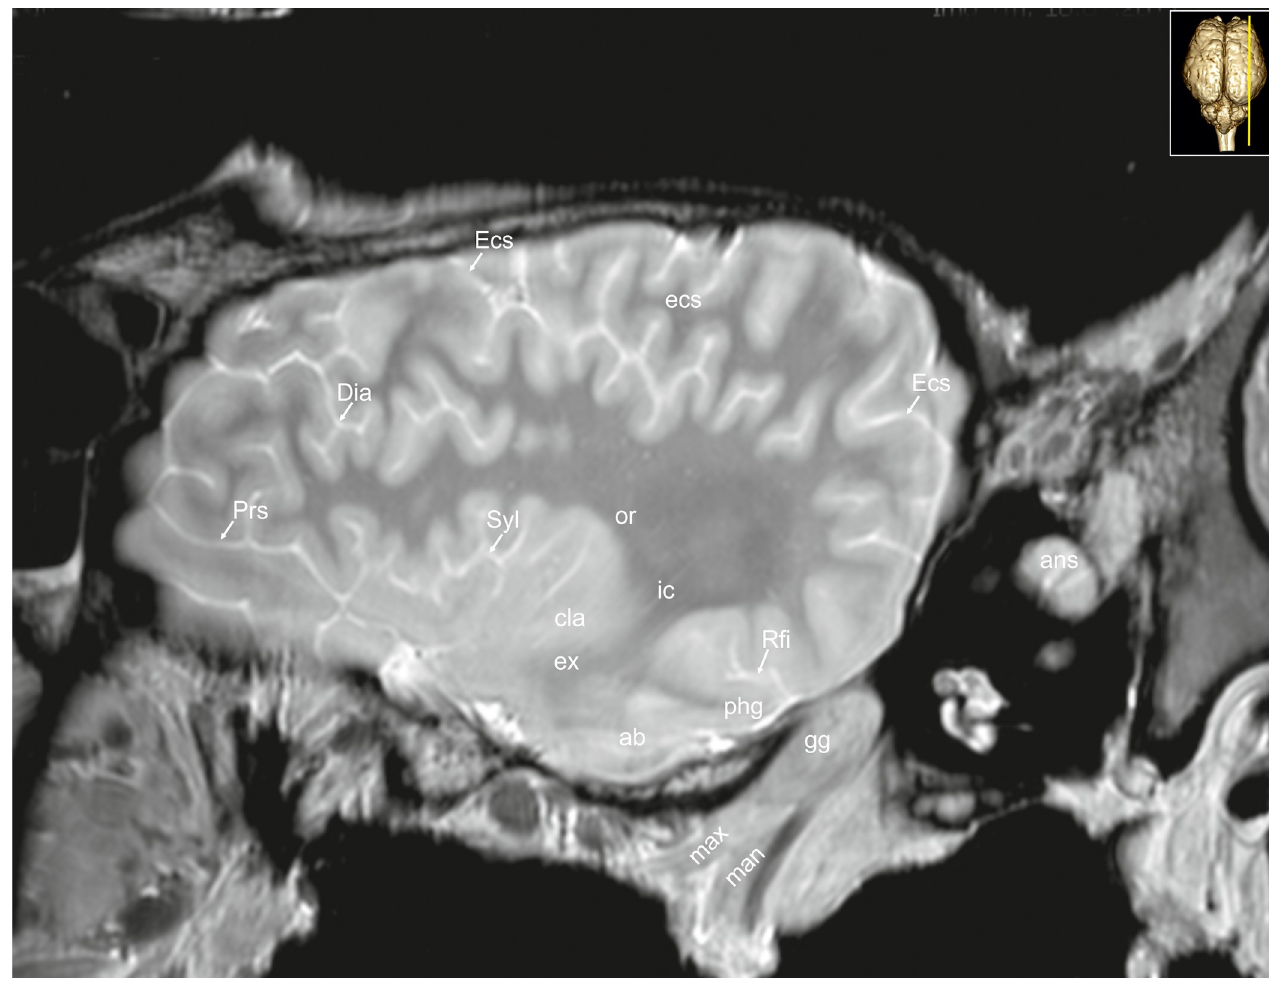
Fig 34. Parasagittal magnetic resonance image of the equine brain at the level of the external capsule. ab: amygdaloid body, ans: ansiform lobule, cla: claustrum, Dia: diagonal sulcus, Ecs: ectosylvian sulcus, ecs: ectosylvian gyrus, ex: extreme capsule, gg: Gasserian ganglion, ic: internal capsule, man: mandibular nerve, max: maxillary nerve, or: optic radiation, phg: parahippocampal gyrus, Prs: presylvian sulcus, Rfi: rhinal fissure, Syl: sylvian fissure.